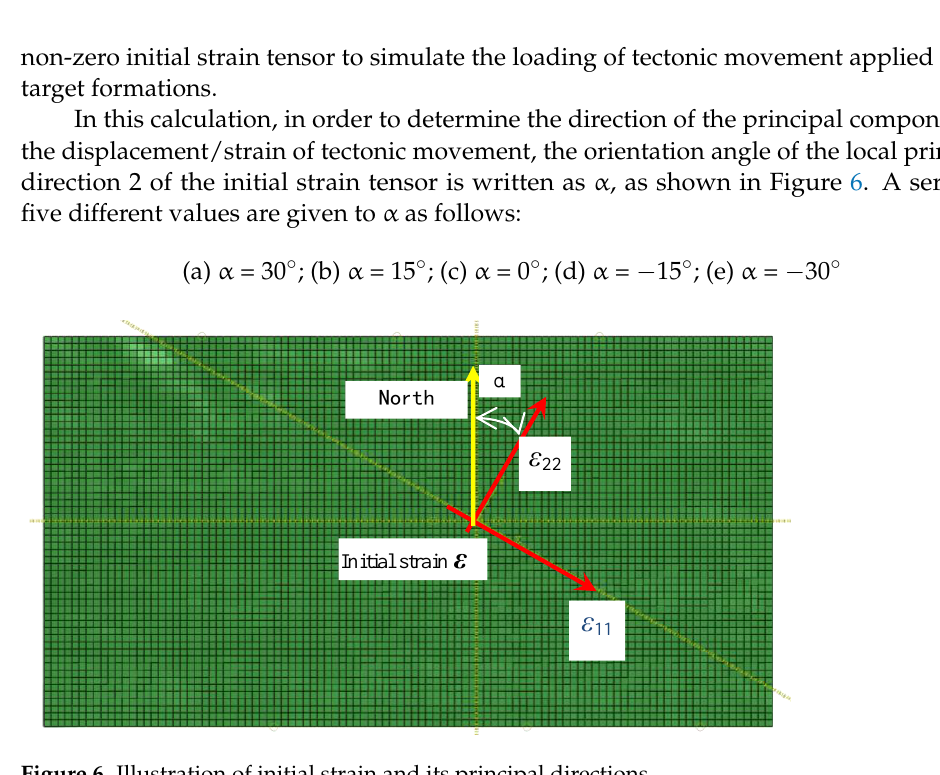
Table 1. Values of parameters of damage evolution under compression.